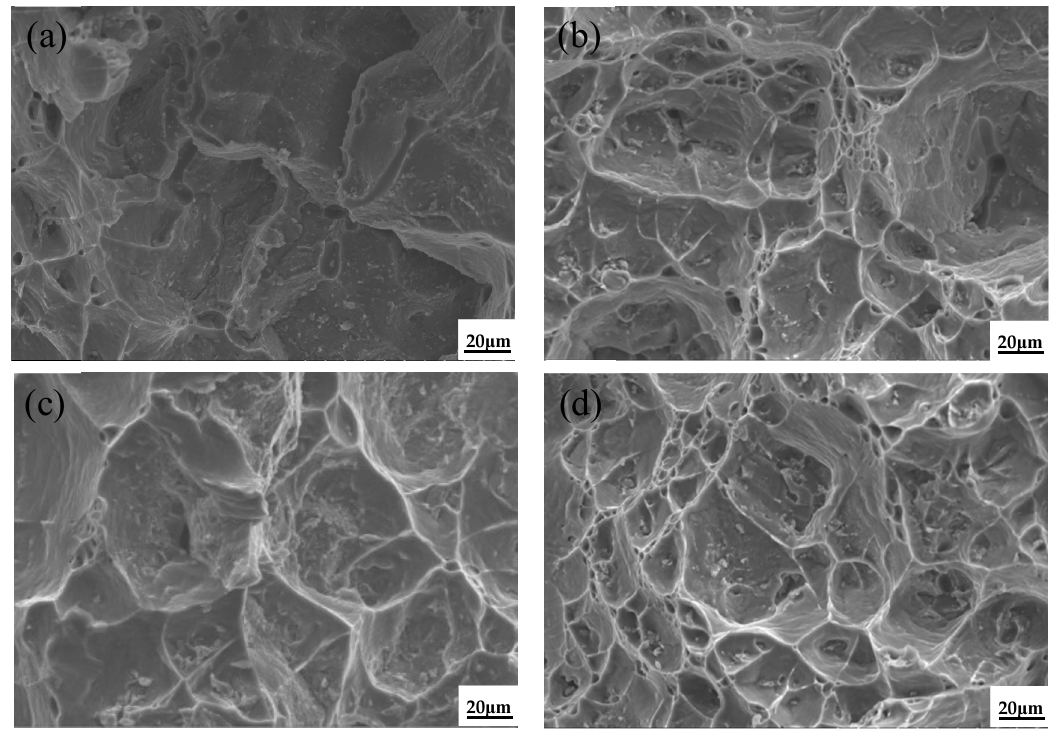
Figure 11. Tensile fracture morphology of T5 heat-treated alloy at 300 °C: ( a ) ZL205A alloy, ( b ) ZL205A + 0.1%La alloy, ( c ) ZL205A + 0.3%Al–5Ti–0.8C alloy, and ( d ) ZL205A + 0.1%La + 0.3%Al–5Ti–0.8C alloy.